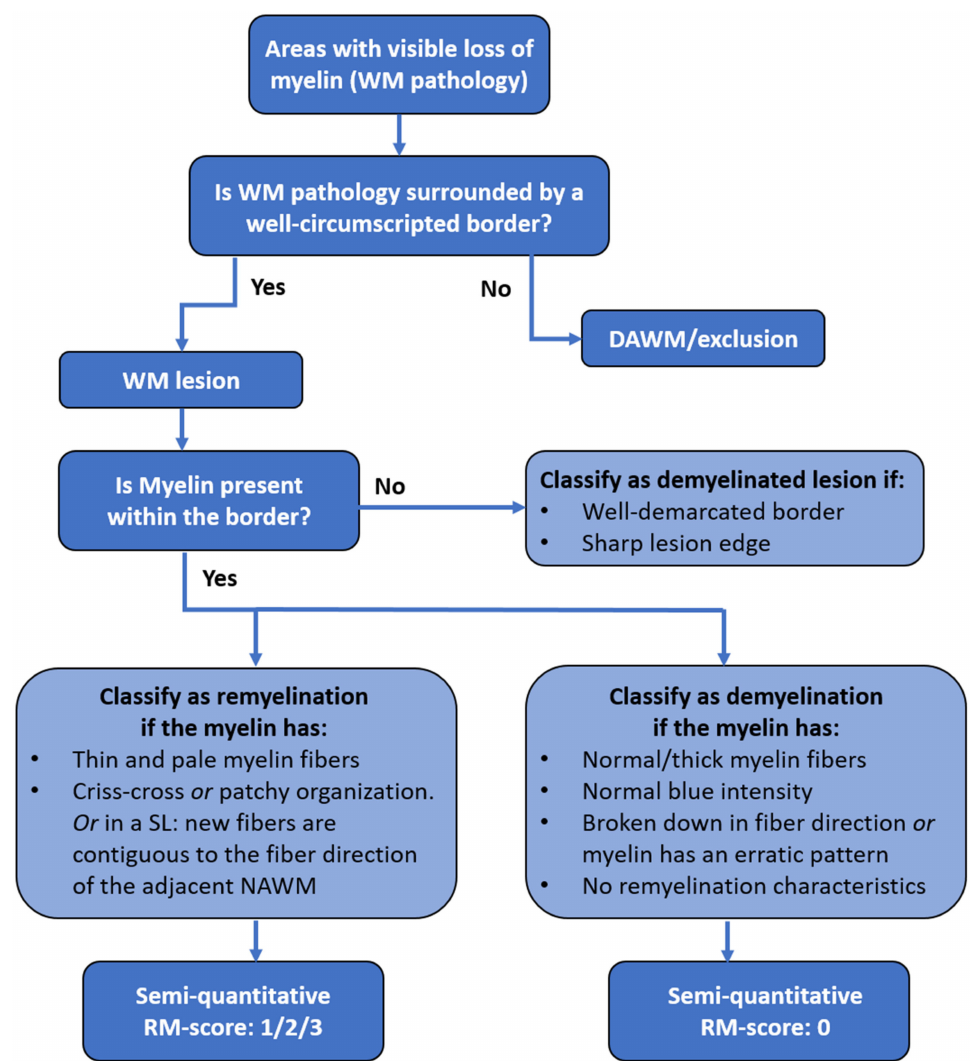
Figure 4. Flowchart for in- or exclusion of WM pathology and for classification of a lesion as a de- or remyelinating lesion. When WM pathology did not contain a well-demarcated border, it was classified as diffusely appearing WM (DAWM) and excluded from further analysis. The next step is to determine if there is myelin present within the border and to classify this as de- or remyelination using the semi-quantitative remyelination score. With (0) demyelination (0%, no remyelinating characteristics); (1) little remyelination (up to 20% restricted to the lesion rim); (2) substantial remyelination (21–60% of lesion area remyelinated, either confluent or patches of remyelination) and (3) nearly complete remyelination (>60%, covering the entire lesion area, SL)